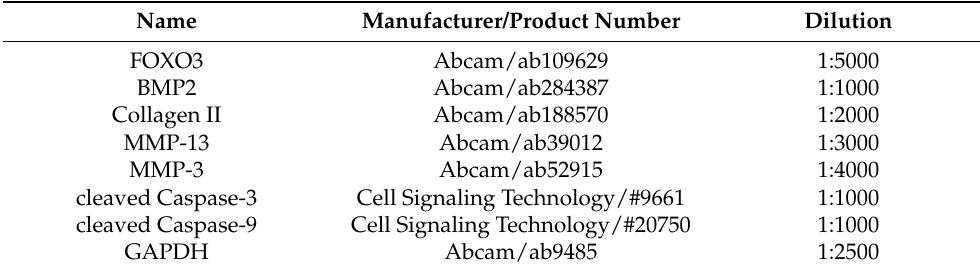
Table 3. The primary antibodies used in this study for Western